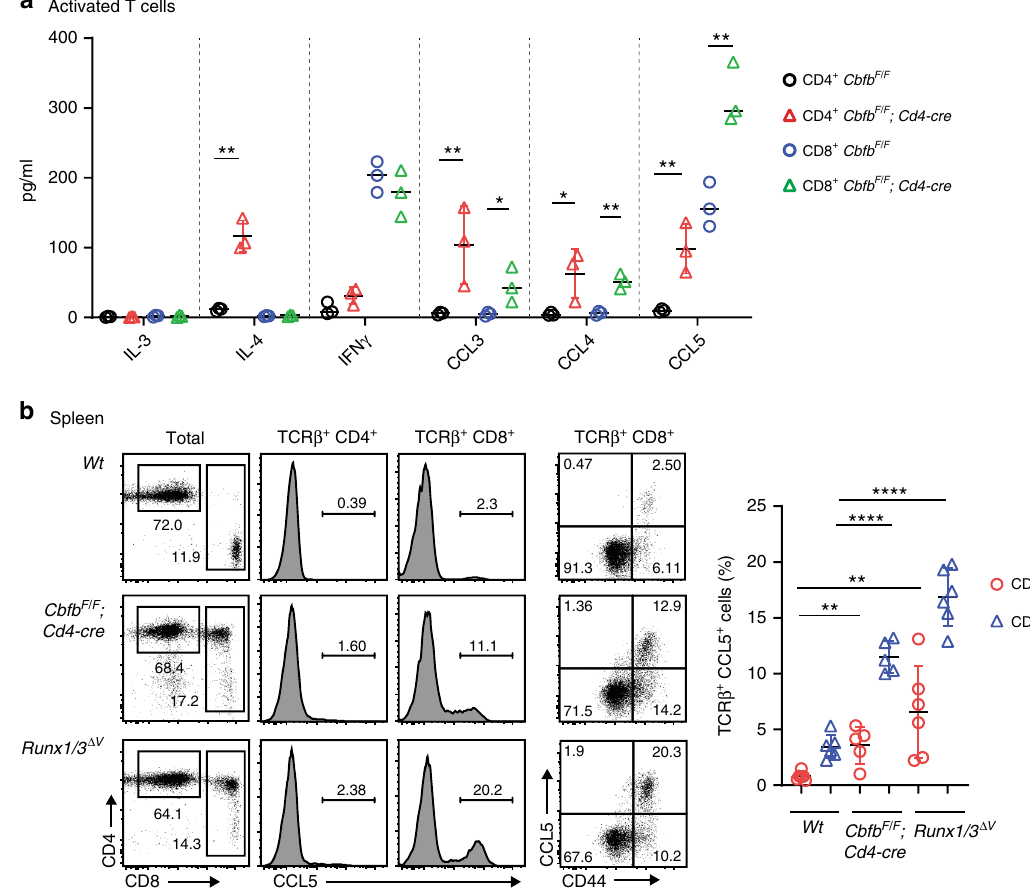
Fig. 1 Ccl5 expression from T cells is repressed by RUNX/CBF β complexes. a Expression pro fi les assessed by ELISA of CCL3, CCL4, and CCL5 and the selected cytokines IL-3, IL-4, and IFN γ in supernatants of in vitro-stimulated CD4 + and CD8 + T cells at 5 days after stimulation. A summary of three independent measurements on three mice (with their genotypes indicated) are shown. Error bars indicate Mean ± SD and each dot represents a mouse examined over at least two independent experiments. Statistical signi fi cance is measured via unpaired two-tailed Student ’ s t tests and is presented as follows: * p < 0.05, ** p < 0.01. b Flow cytometry analysis of total splenocytes and splenic TCR β + T cells in mice with their genotypes indicated. One representative pro fi le of the CCL5 expression is shown in the histograms and dot plots. Numbers in the dot plots indicate the percentage of cells in each quadrant. Error bars indicate Mean± SD and each dot represents a mouse examined over at least two independent experiments. Statistical signi fi cance